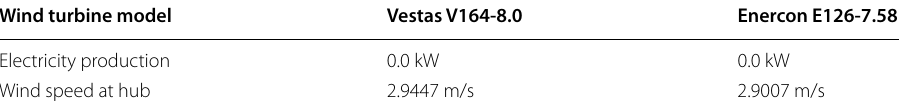
Table 4 Scenario 3 wind turbine results